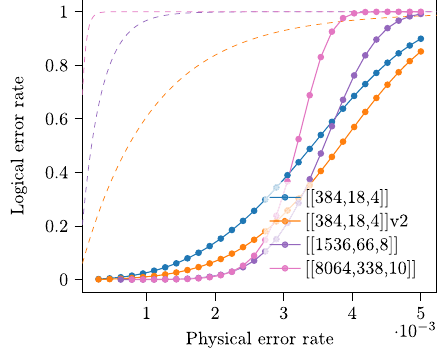
FIG. 31. Performance of the extremal subsystem f 8 ; 4 g l ¼ 2 semihyperbolic codes under a circuit-level depolarizing noise model. A homogeneous ð ZX Þ 20 schedule is used for all codes, and the y axis is the probability that at least one logical Z error occurs. Dashed lines are the probability of a Z error occurring on at least one of k physical qubits without error correction under the same error model and for the same duration (80 time steps), with k ¼ 4 (orange), k ¼ 8 (purple), and k ¼ 10